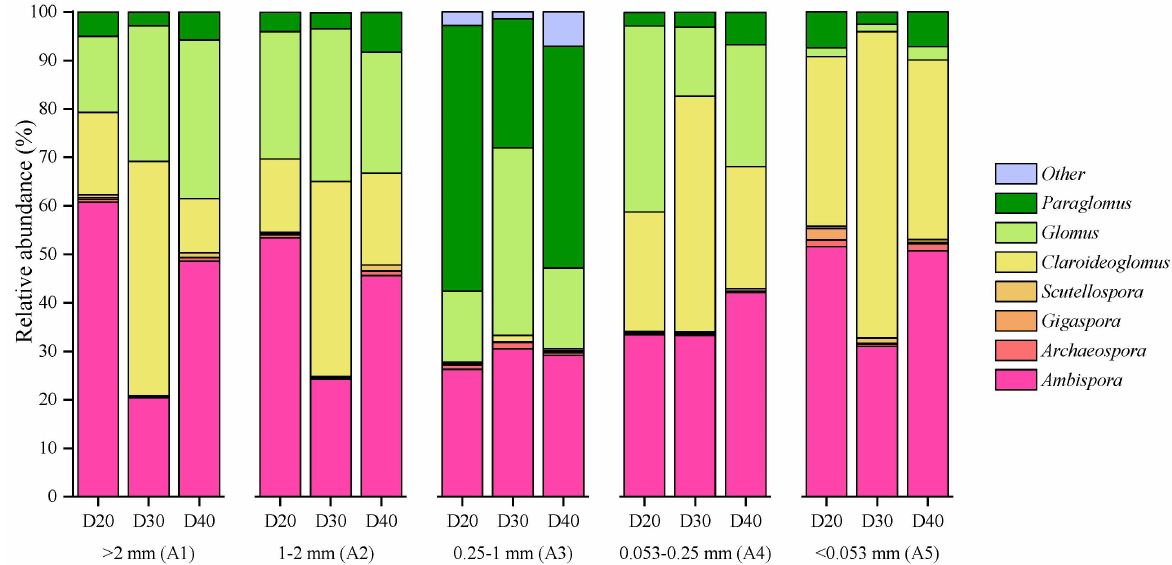
Figure 4. Genera and relative abundance of AMF in the soil aggregates. Note: A, aggregate size class (A1: >2 mm, A2: 1–2 mm, A3: 0.25–1 mm, A4: 0.053–0.25 mm, A5: <0.053